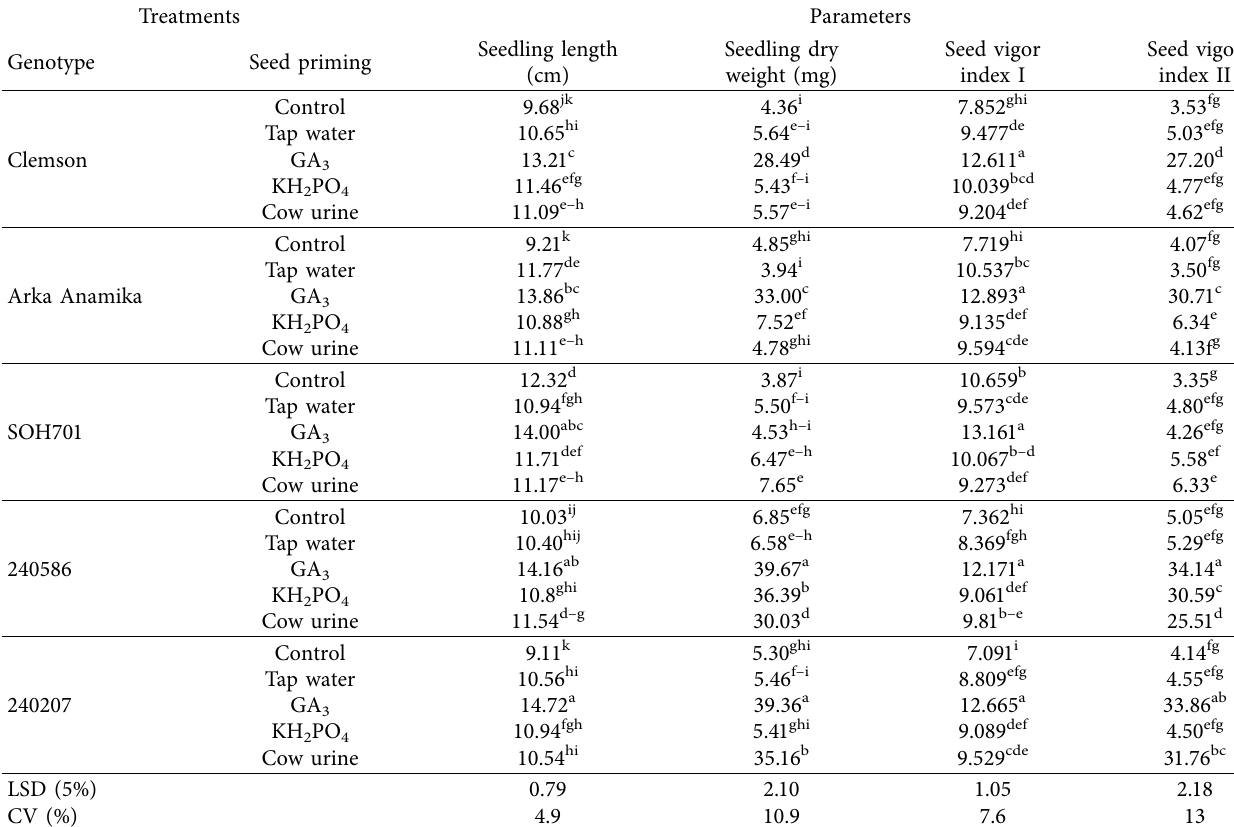
Table 6: Interaction efects of genotype and diferent priming on seedling length, dry weight, and seed vigor index I and II.